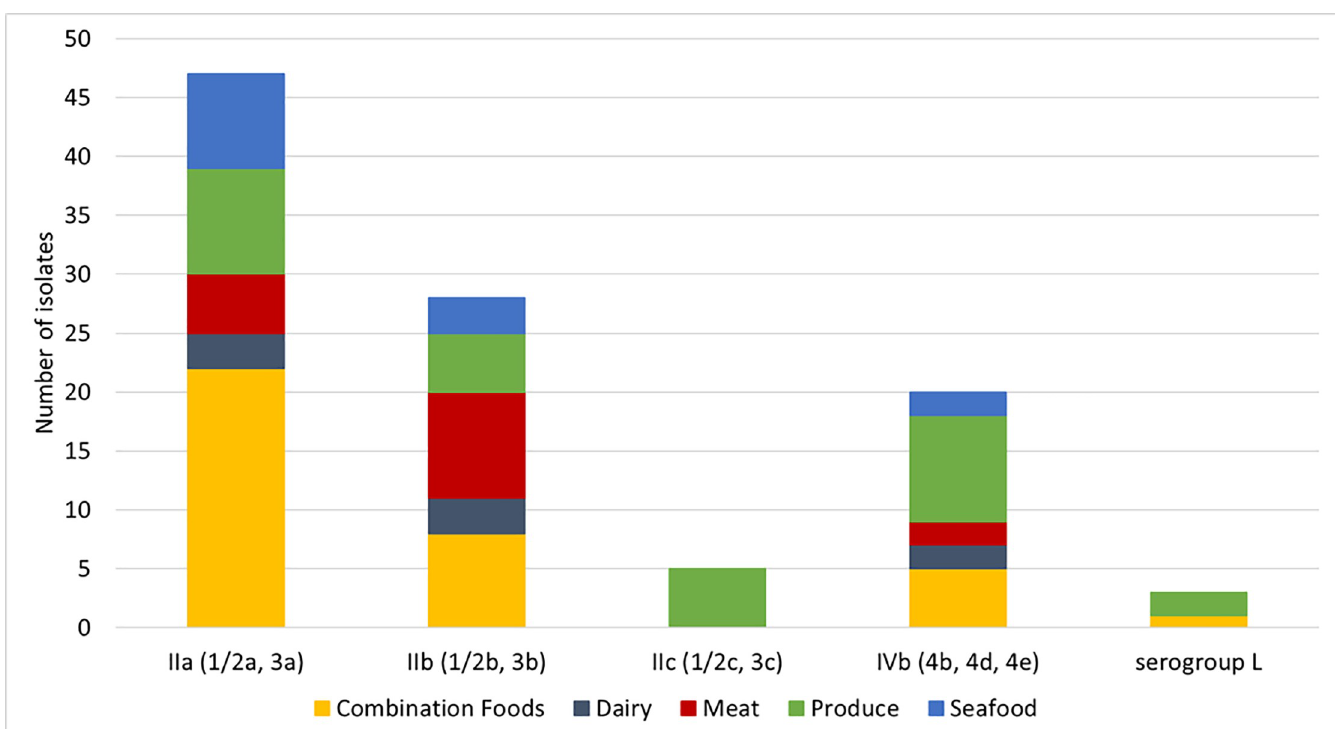
Fig 2. Prevalence of serogroups IIa, IIb, IIc, IVb, and L among L . monocytogenes isolates (n = 102) obtained from five food groups. Serogroup L does not have the markers of serogroups IIa, IIb, IIc and IVb. WGS determined that one serogroup L isolate belonged to lineage I and the other two serogroup L isolates belonged to lineage III.